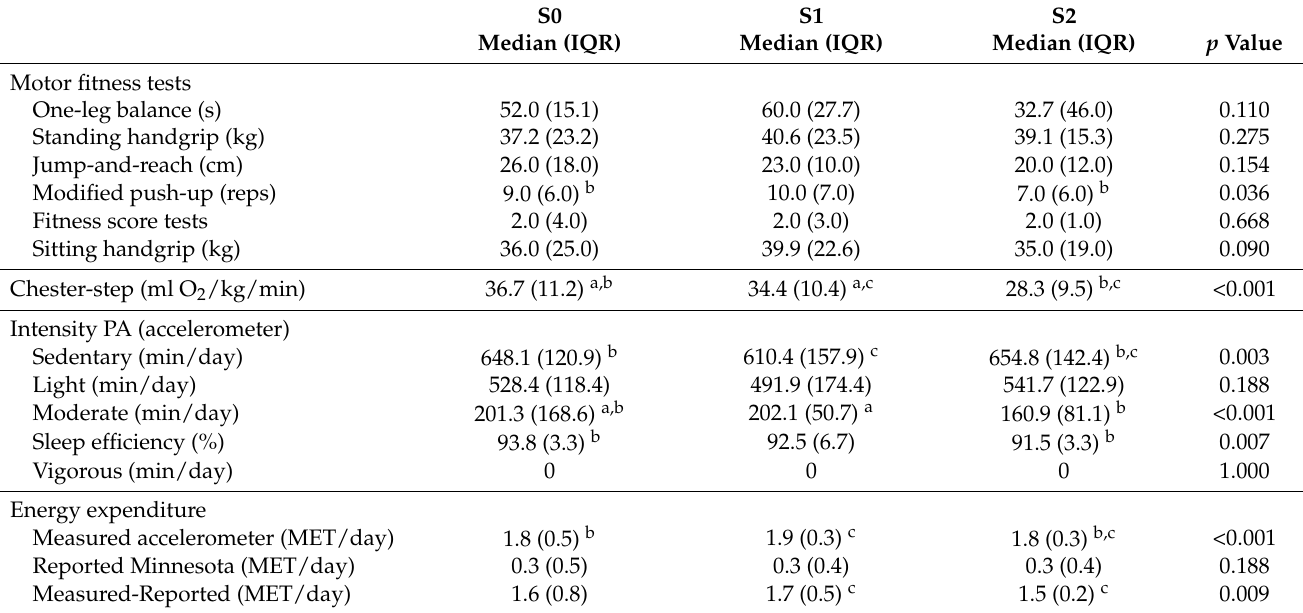
Table 2. Physical activity parameters between participants with different stages of hepatic